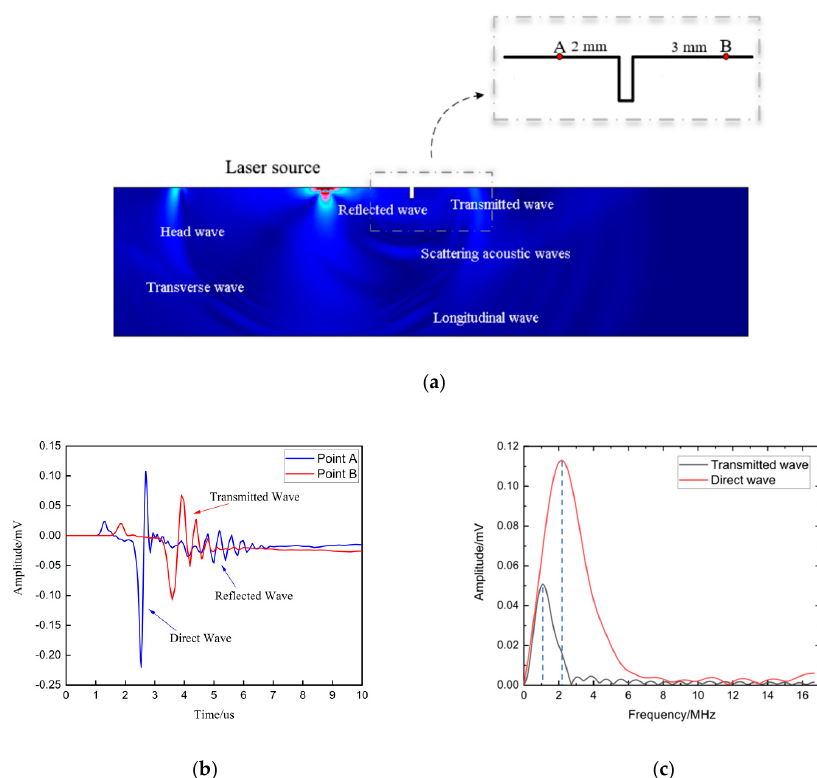
Figure 4. ( a ) Simulation acoustic field; ( b ) acoustic wave in the time domain; ( c ) acoustic wave in the frequency domain.